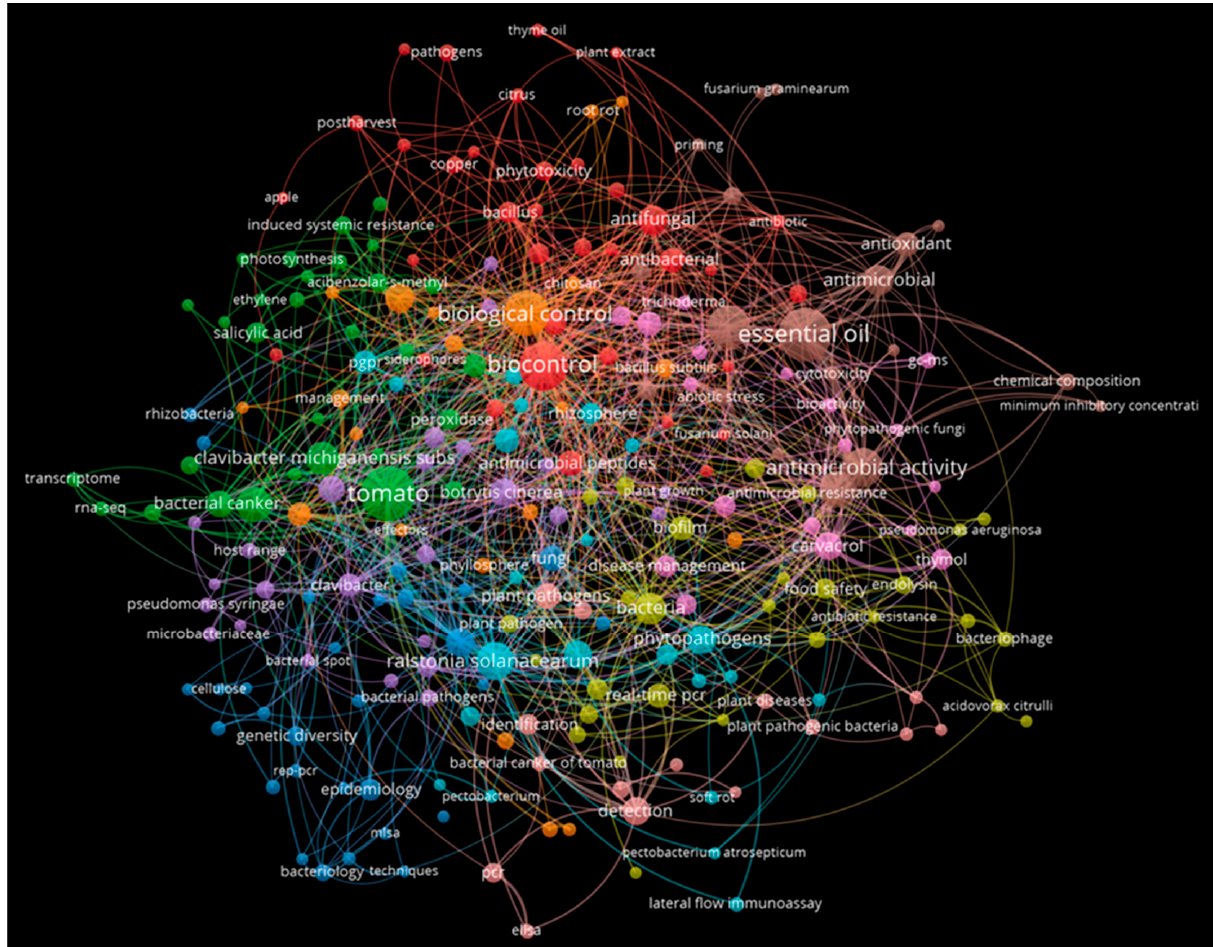
Figure 1. The bibliometric analysis illustrates the distribution of the most relevant articles in the control of bacterial canker of tomato caused by the pathogenic actinobacterium Clavibacter michiganensis.